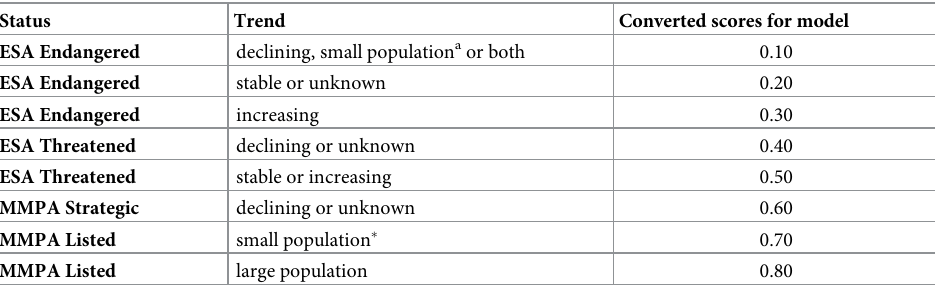
A generalized scoring system for Endangered Species Act (ESA)-listed species and Marine Mammal Protection Act (MMPA)-listed stocks. A stock is defined by the MMPA as a group of marine mammals of the same species or smaller taxa in a common spatial arrangement that interbreed when mature. a Small population equates to populations of 500 individuals or less